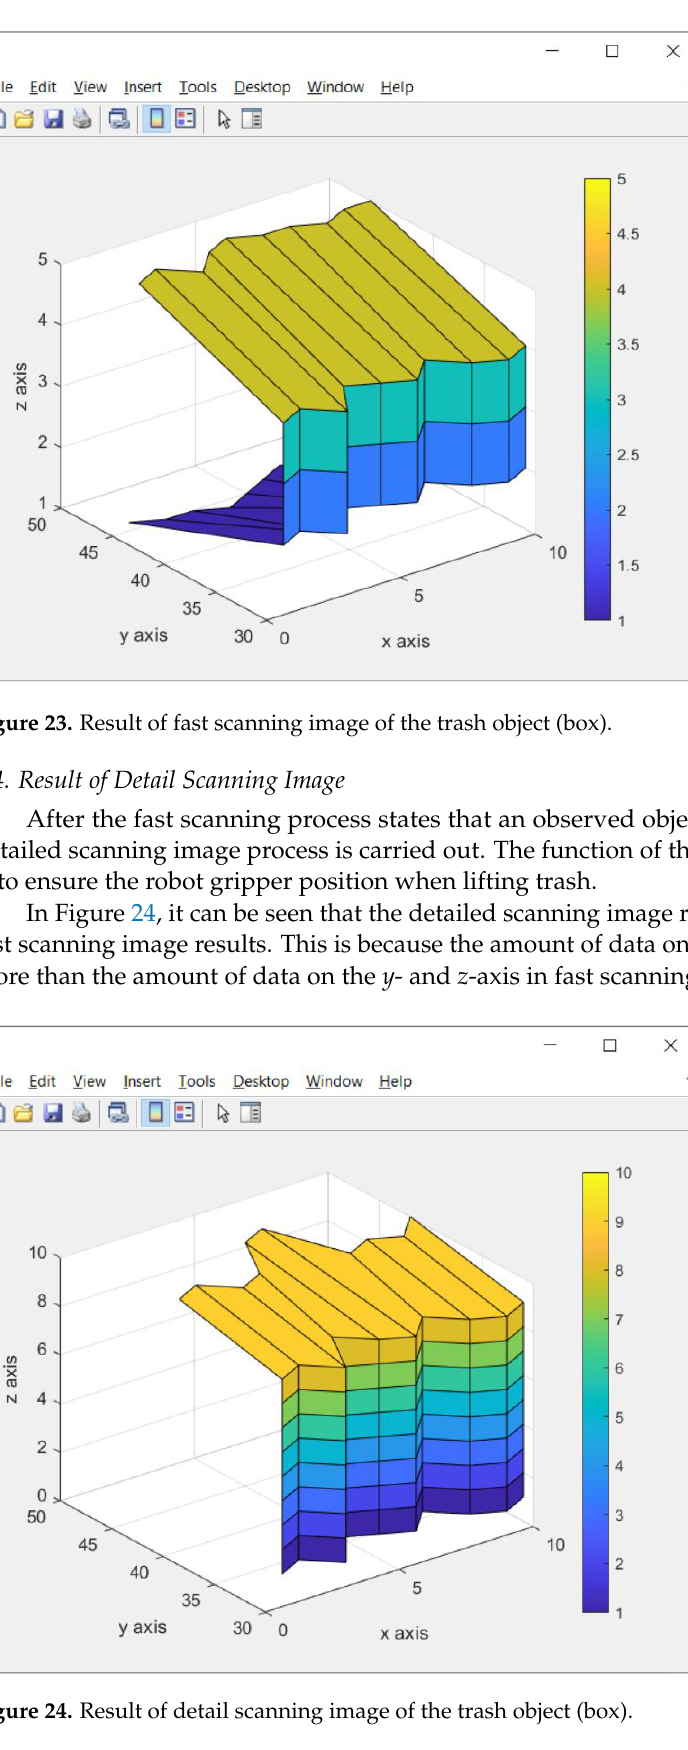
Figure 24. Result of detail scanning image of the trash object